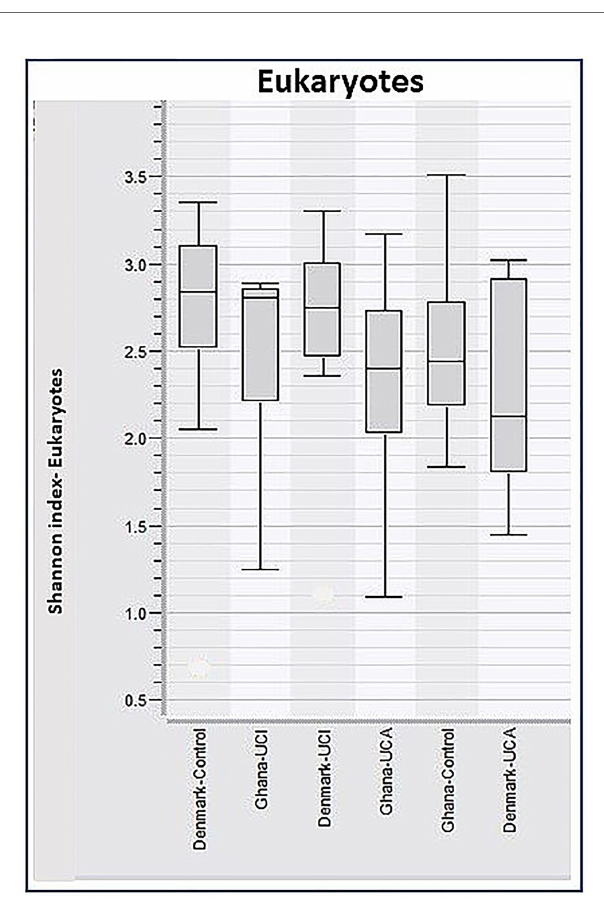
FIGURE 6 | Boxplots of calculated Shannon Diversity Index, divided by groups show increased eukaryotic diversity in healthy controls. However, these differences are not signi fi cant.